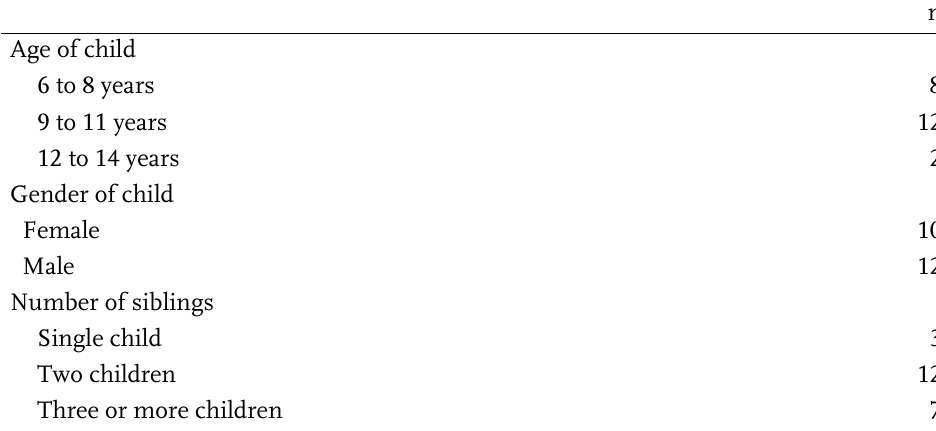
Table 3 Sociodemographic characteristics of interviewed children (qualitative